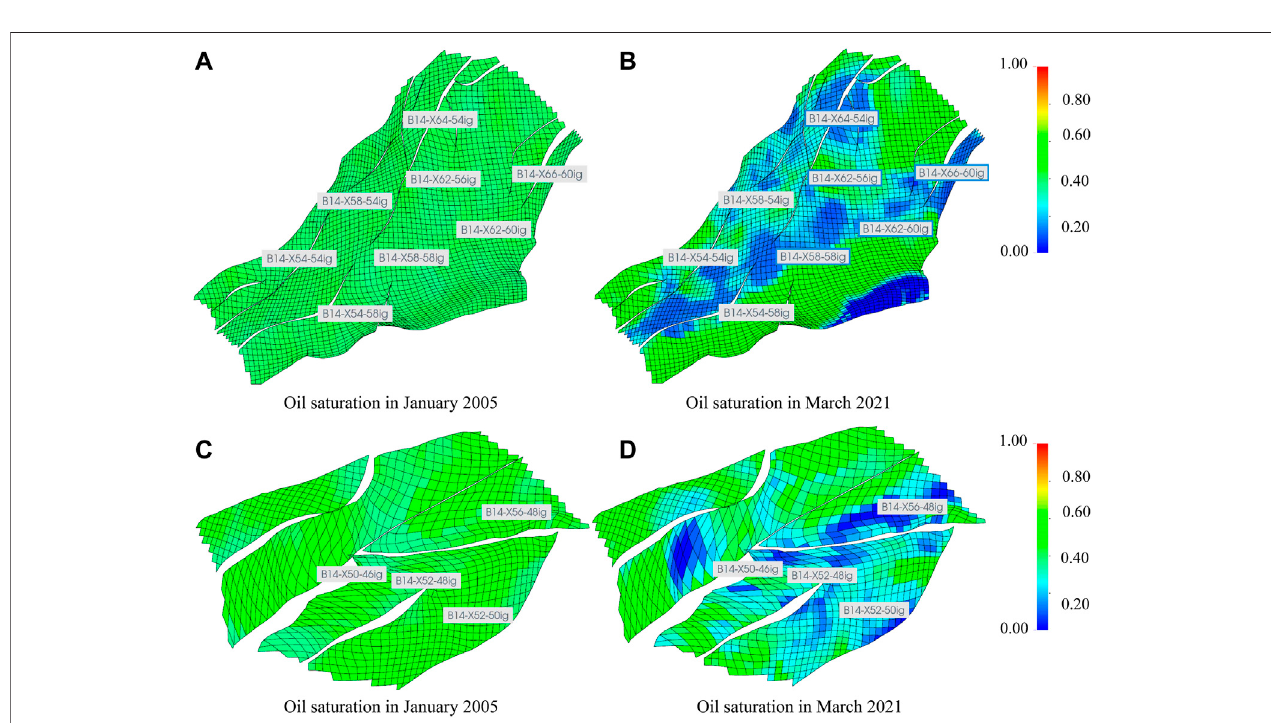
FIGURE 7 | (A,B) Oil saturation of simulated layer 23 in B2; (C,D) oil saturation of simulated layer 17 in B3.